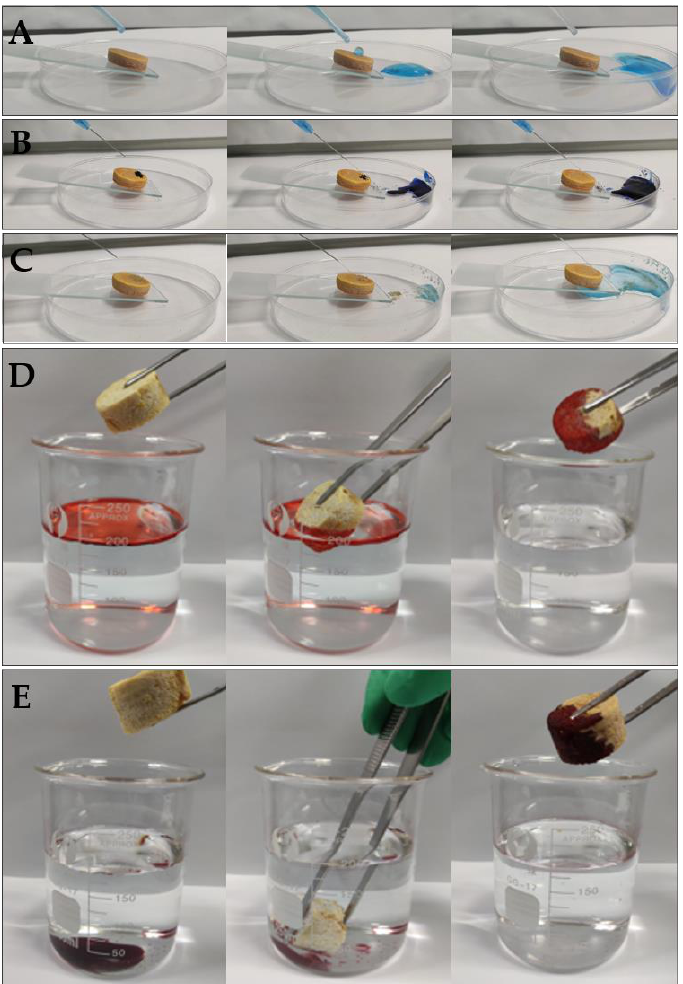
Figure 6. Methyl blue dyed water rolling off the surface ( A ), methylene blue powders ( B ) and sands washed away by running water ( C ), removal of petroleum ether ( D ), and dichloromethane ( E ) (dyed with Oil red O) from the surface and bottom of water with F-CS aerogel.